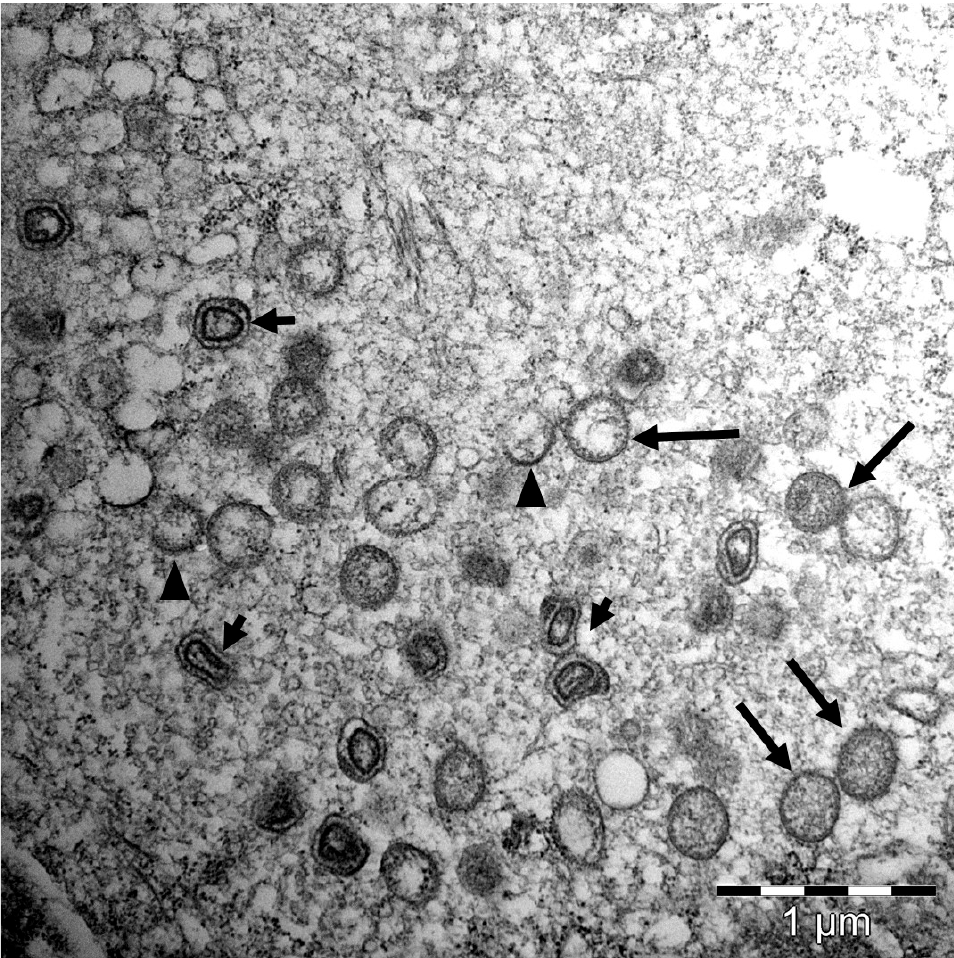
Figure 3. Transmission electron microscopy of the inside of a salmon gill epithelial cell infected with SGPV showing different stages of SGPV morphogenesis. Crescents (arrowheads), immature virions (large arrows), and mature virions (small